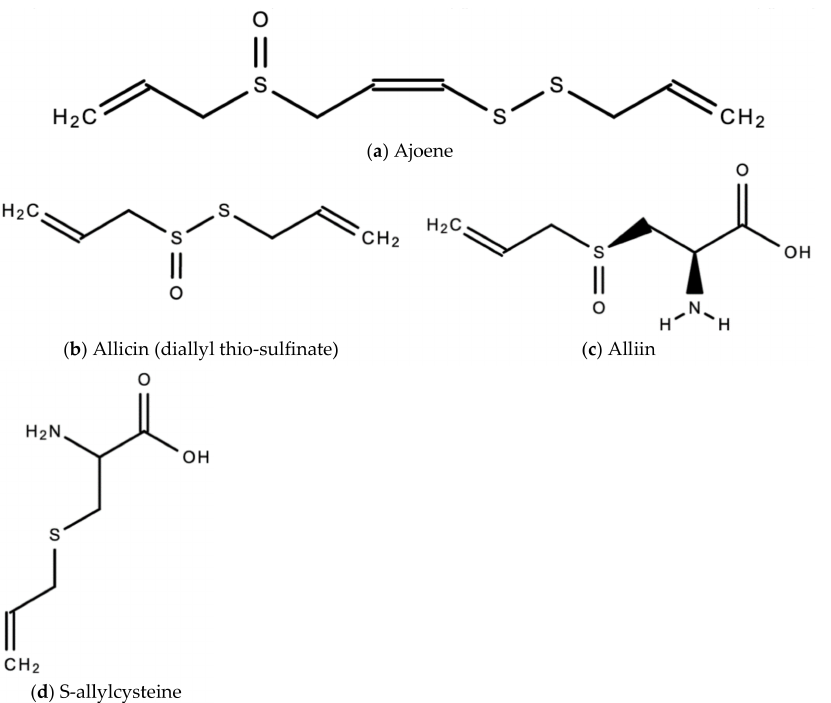
Figure 16. Chemical structures of some bioactive molecules found in